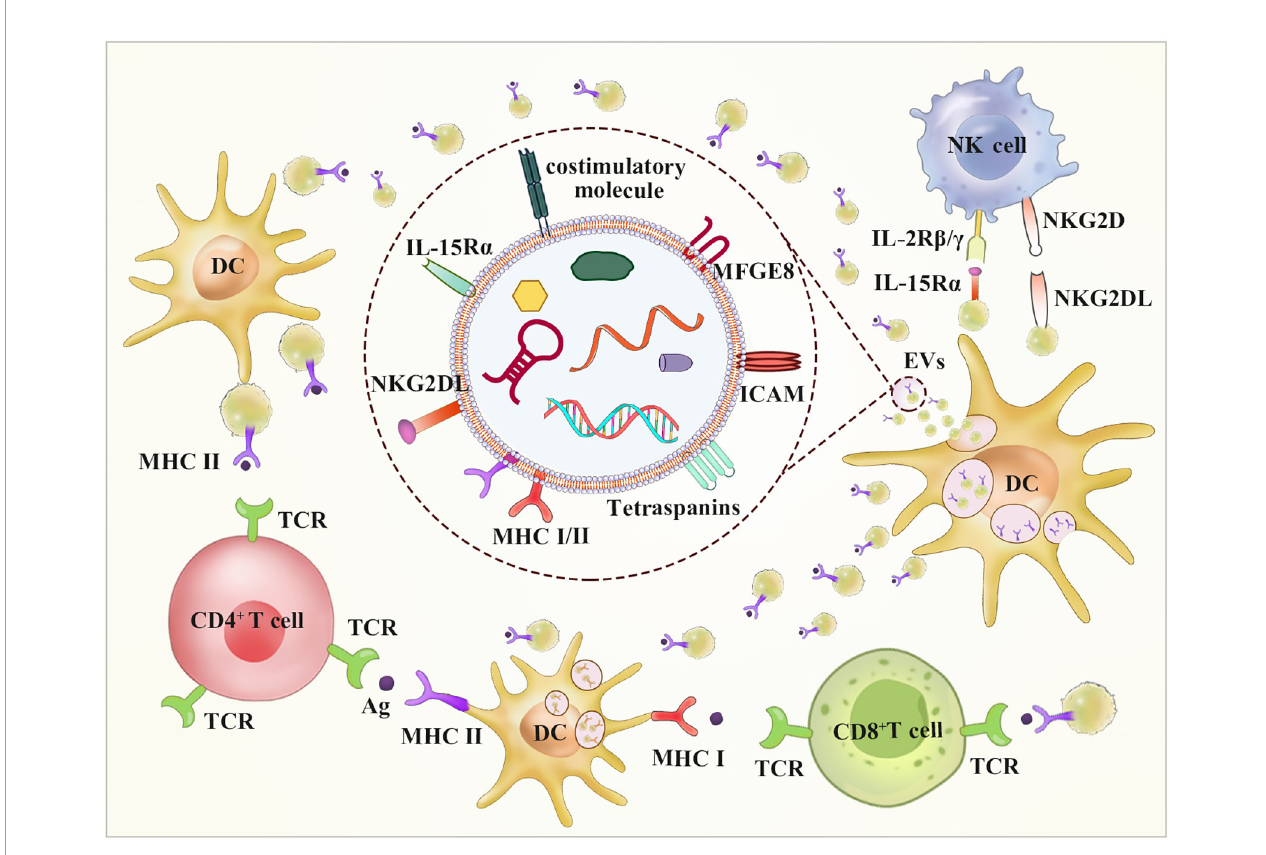
FIGURE 3 | DC-derived EVs may stimulate both CD8 + and CD4 + T cells by direct and indirect routes. A route for DC EVs stimulation of T cells occurs directly via the expression of MHC-I, MHC-II and costimulatory molecules on the surface of it. The indirect way stimulation of T cells occurs via bystander DCs through two mechanisms. The fi rst way involves EVs internalization and transfer of antigen-MHC complex. The other way called cross-dressing involves antigen-MHC complex direct transfer to DC surface. Additionally, DC EVs have been shown to possess NKG2D-L and the IL-15/IL-15R a complex, which can result in NK